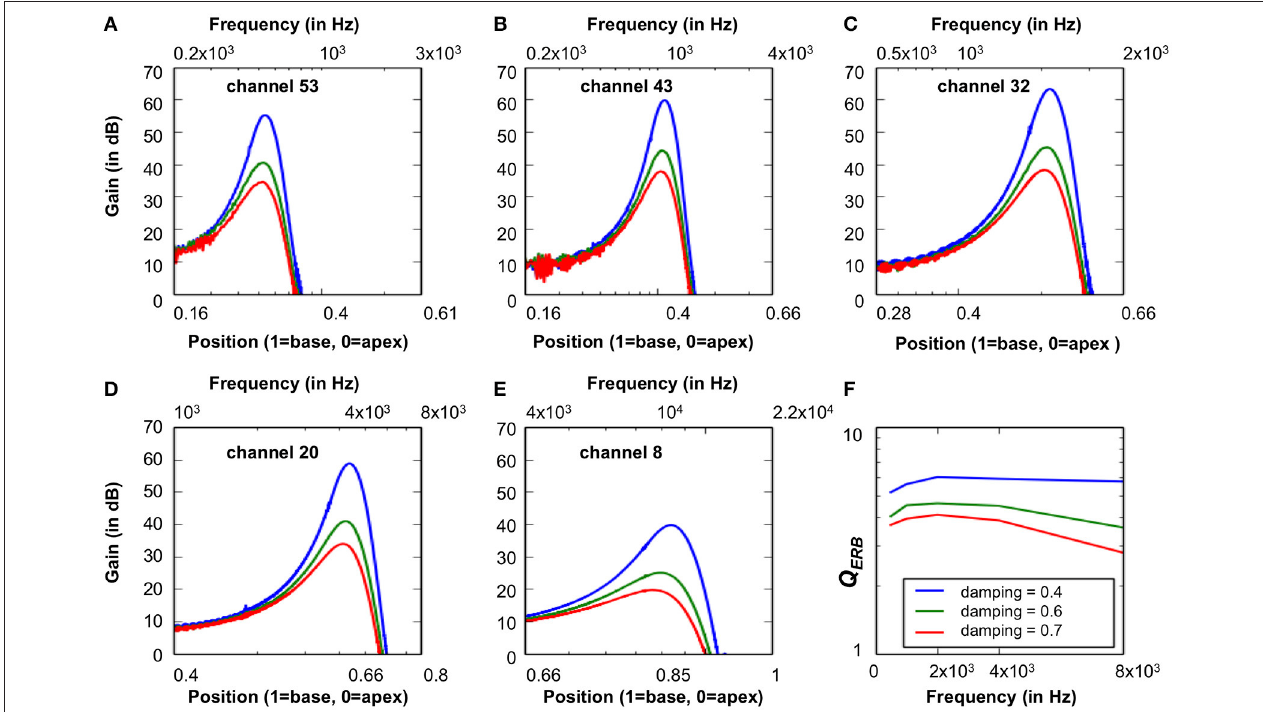
FIGURE 12 | (A–E) The CAR-FAC system response calculated at the CFs corresponding to 0.5, 1, 2, 4, and 8kHz with three damping factors (0.4, 0.5, and 0.7) in Equation (11). The x-axis shows both the frequency and the BM location calculated from Equation (9). (F) The corresponding Q ERB at CFs corresponding to 1, 0.5, 2, 4, and 8kHz estimated from the BM impulse response PSD at CFs.